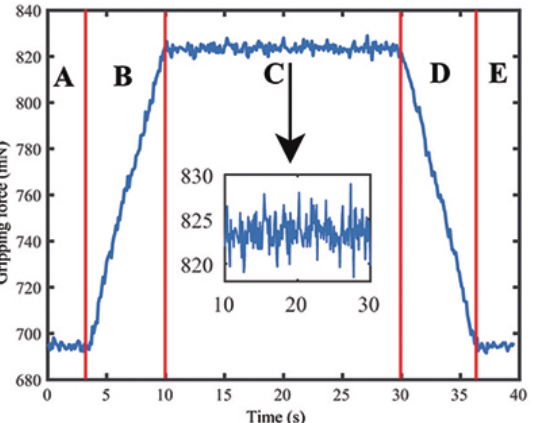
Figure 13. Experimental result of the gripping force when grasping a metal micro-wire with the diameter of 350 µ